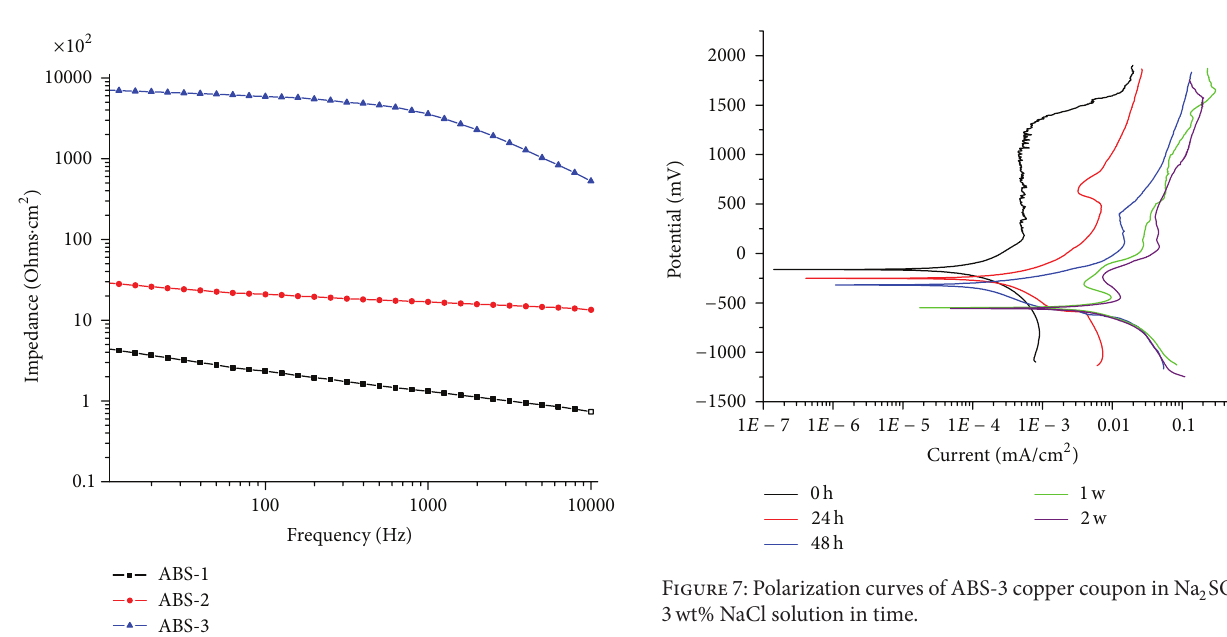
Figure 5: Copper coated with varnish in Na 2 SO 4 + 3wt% NaCl solution in time: (a) Bode impedance diagrams and (b) electrochemical resistance noise.